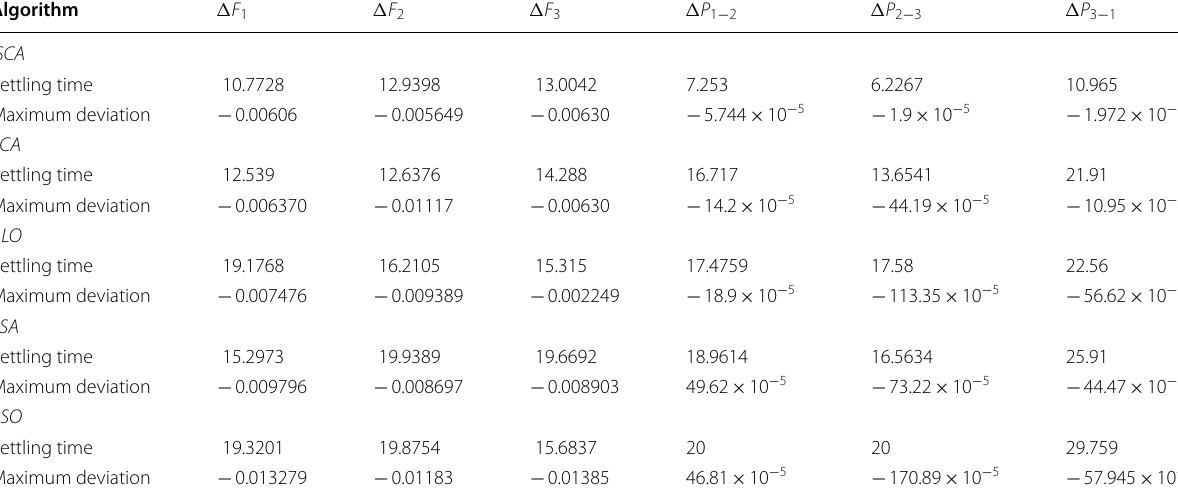
Table 6 Performance parameters of LFC with ISCA, SSA, ALO, SCA and PSO in the case of SLD of 2% in each area